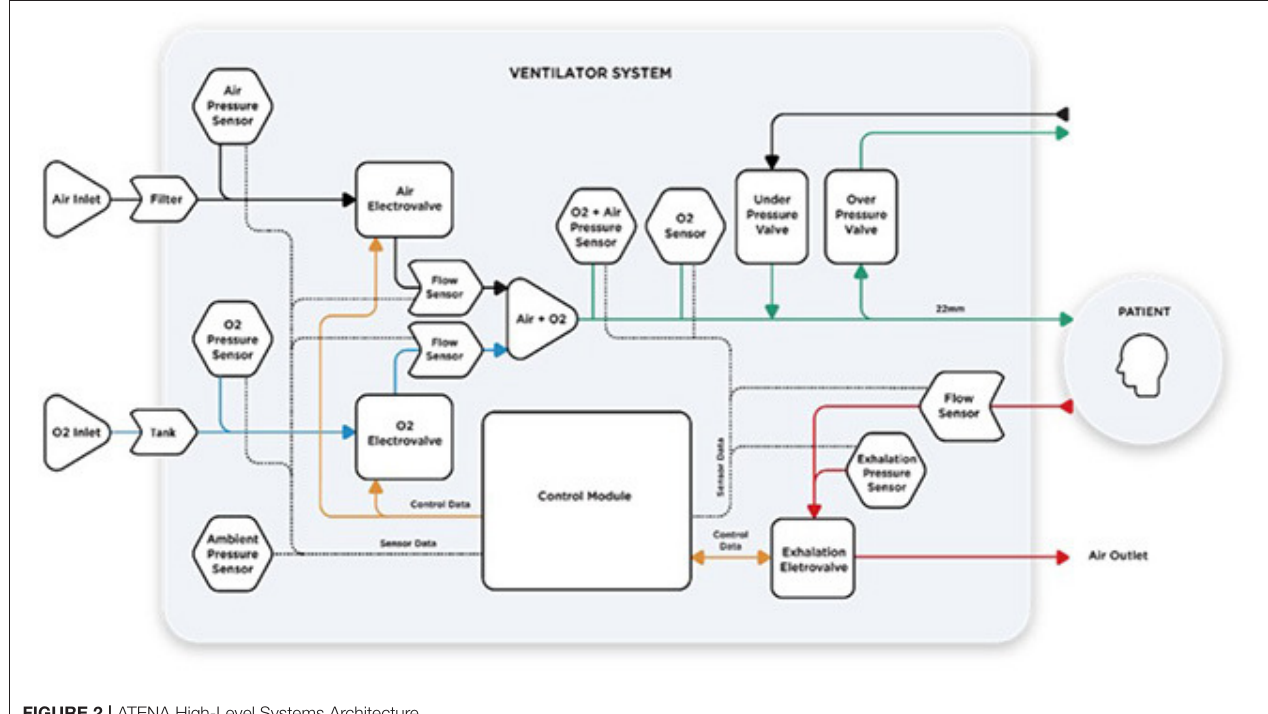
FIGURE 2 | ATENA High-Level Systems Architecture.